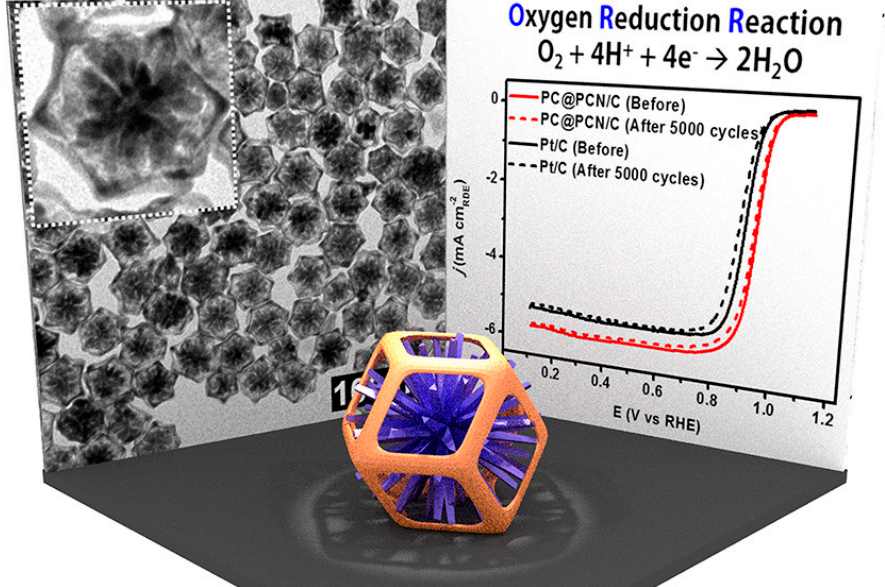
Figure 30. High-angle annular dark-field scanning transmission electron microscopy (HAADF-STEM) image of PC@PCN, oxygen reduction reaction (ORR) polarization curves of PC@PCN/C and commercial Pt/C before and after the cycling test for 5000 cycles, and the schematic illustration of PC@PCN Dendrite@frame Reprinted with permission from [126]. Copyright (2017) ACS, Washington, DC, America.